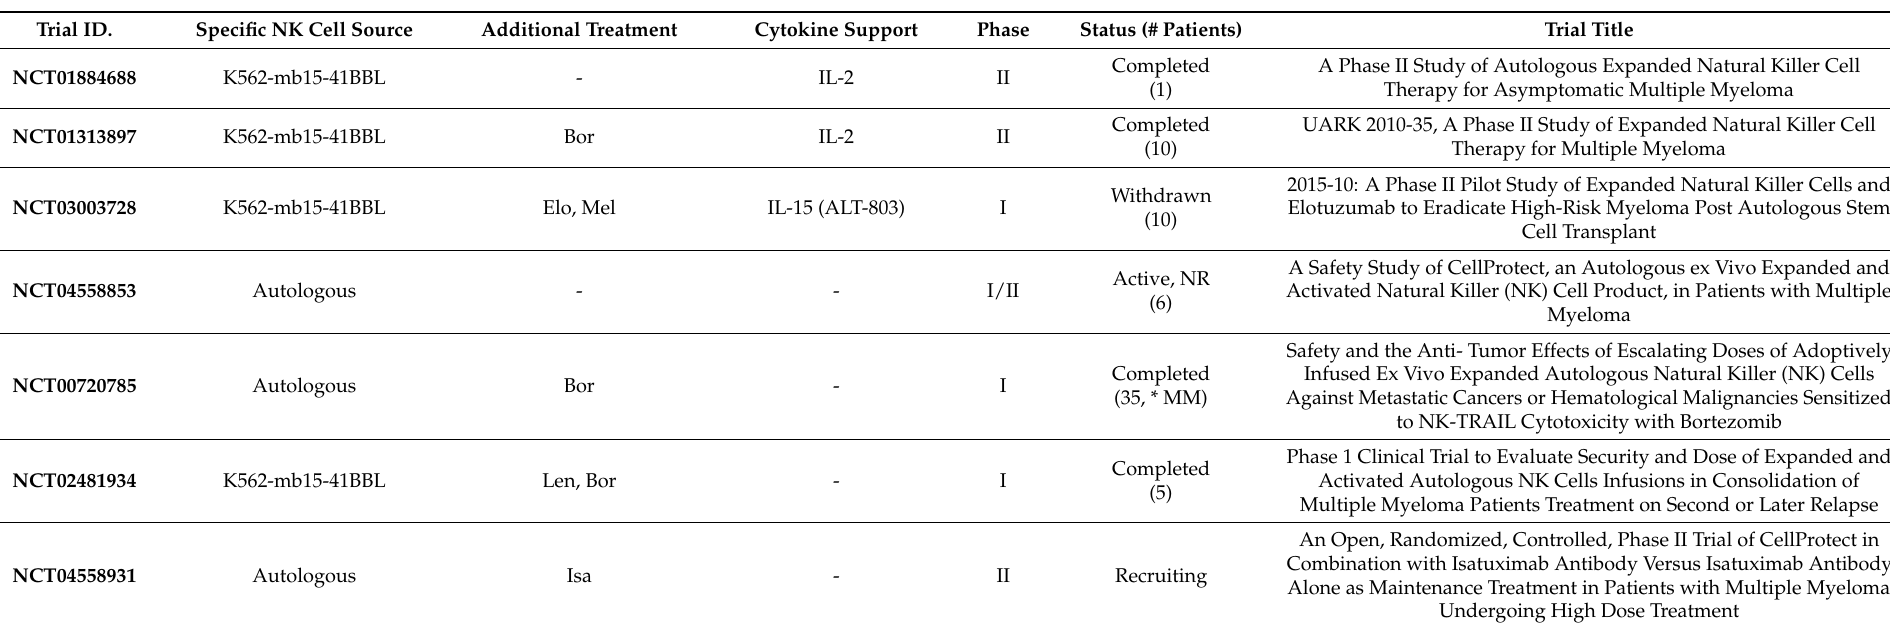
Table 1. Clinical trials based on autologous NK cell infusions. Bor—bortezomib, Elo—elotuzumab, Mel—melphalan, Len—lenalidomide, Isa—isatuximab, NR—not recruiting, * MM indicates that the trial was done in a variety of tumor types and that the number of MM patients was not specified. Trial